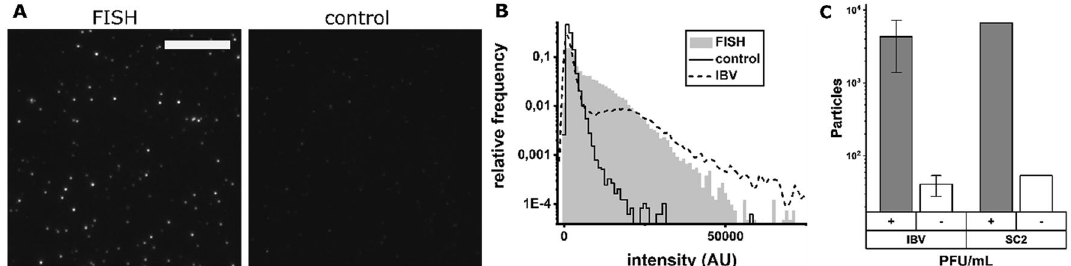
Figure 4. Performance of the virus detection FISH protocol on a virus culture supernatant of SARS-CoV-2 in 0.9% NaCl. ( A ) Images of FISH-stained SARS-CoV-2 (10 4 PFU/mL). Left: SARS-CoV-2 FISH probe set, right: IBV probe set as a negative control. Scale bar 10 µm. ( B ) Intensity distributions of fluorescent spots detected in the samples in ( A ). Grey area: complementary FISH probe set, black line: negative control FISH probe set, dotted line: IBV sample with IBV probes (Fig. 3B, bottom) for comparison. ( C ) Comparison of rvFISH particle counts of SARS-CoV-2 and IBV (both 10 4 PFU/mL). SC2: SARS-CoV-2. Complementary probes (grey, +), non- complementary probes (white,